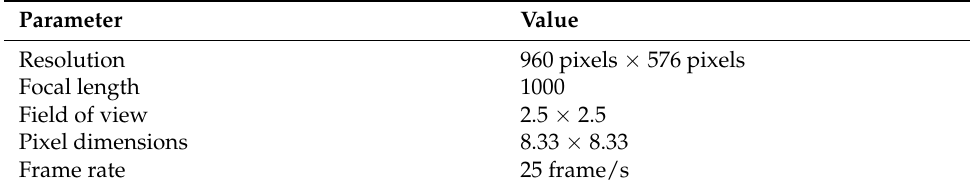
Table 3. Video satellite sensor